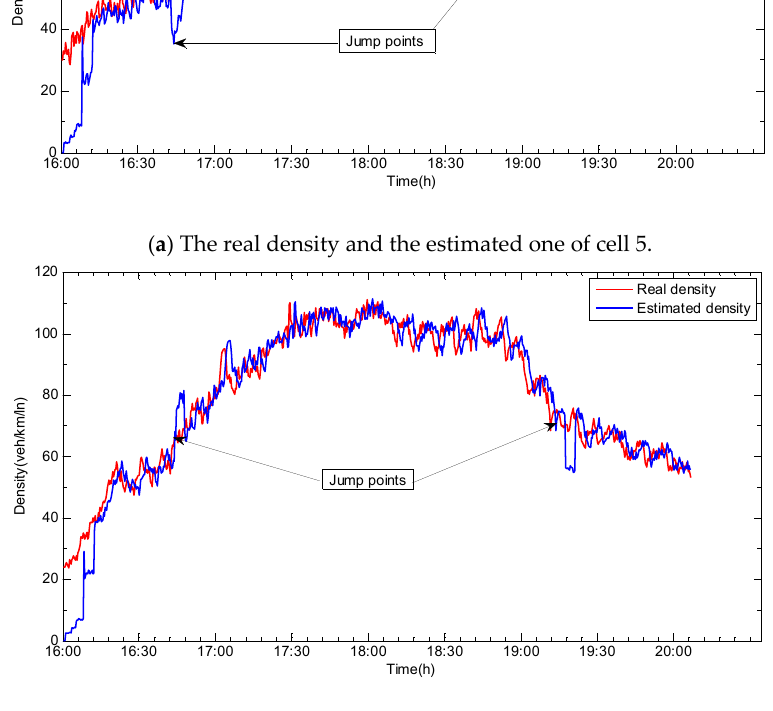
Figure 10. Experimental results of cell 5 and cell 6. ( a ) The real density and the estimated one of cell 5; ( b ) The real density and the estimated one of cell 6.